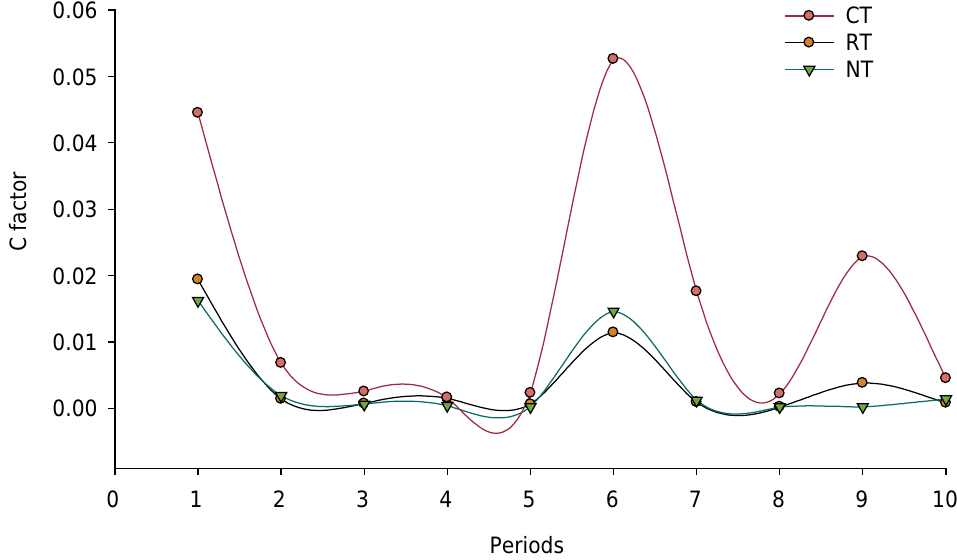
Figure 3. Average of 13 years of C factor of the different wheat-soybean management systems over the 10